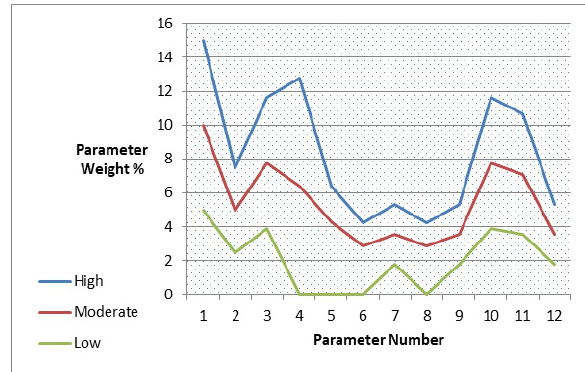
Figure 2: Weight each parameter according to the three classes